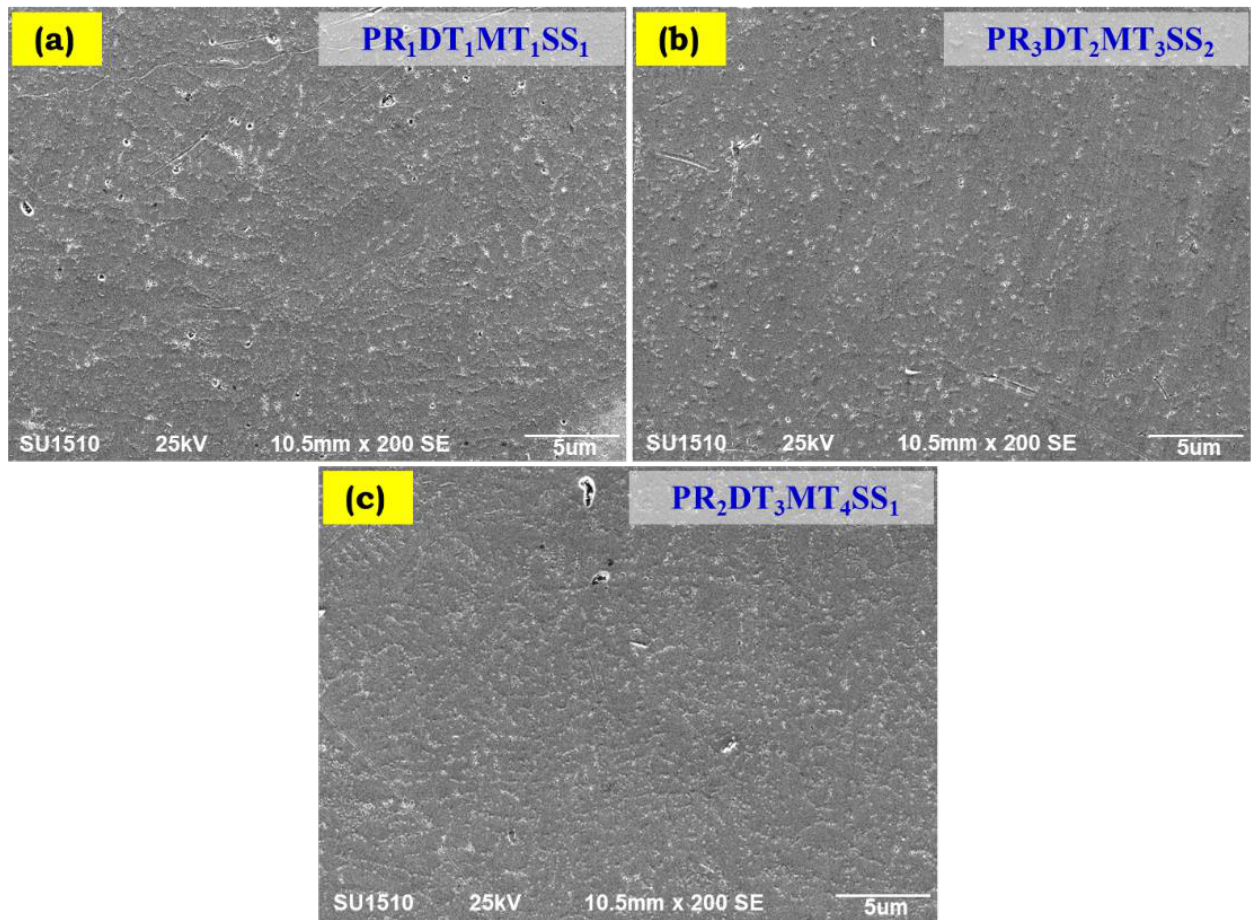
Figure 8. SEM Morphology studies for different stir casting conditions: ( a ) PR 1 DT 1 MT 1 SS 1 Condition